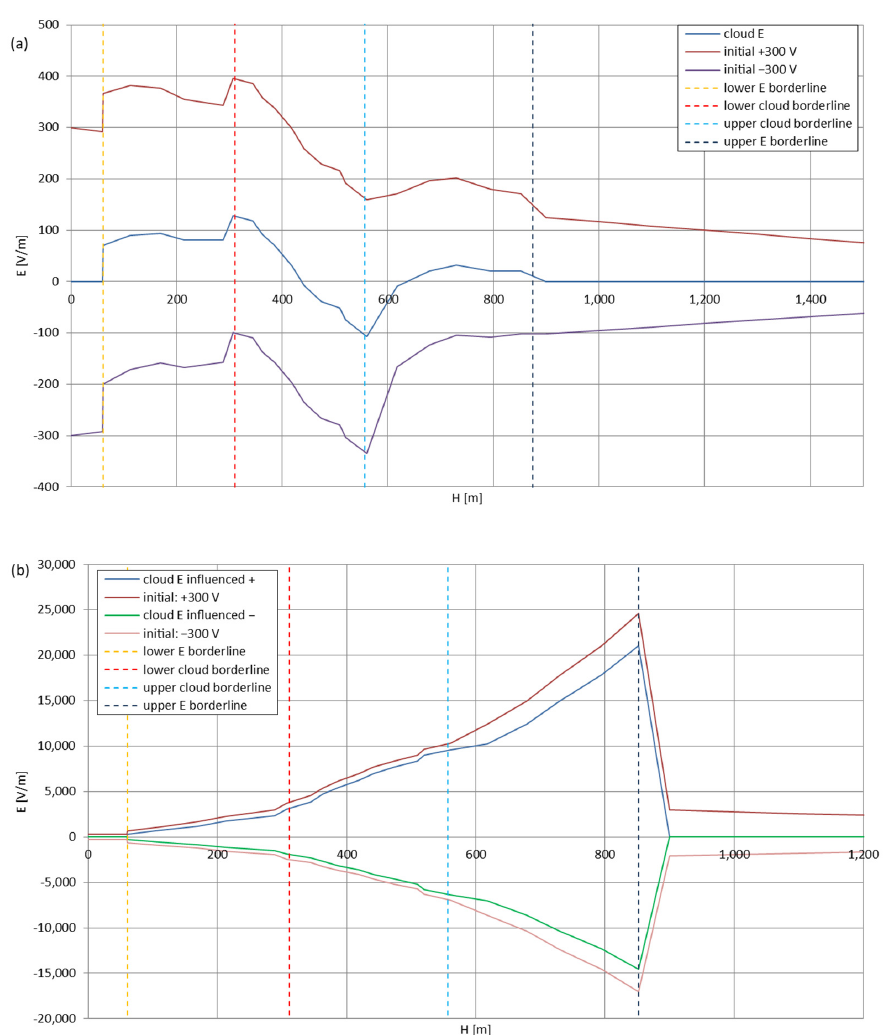
Figure 7. Maximum electric field strengths around the wire antenna passing through Stratocumulus cloud charged positively: ( a ) ‘static’ case and ( b ) ‘dynamic’ case.